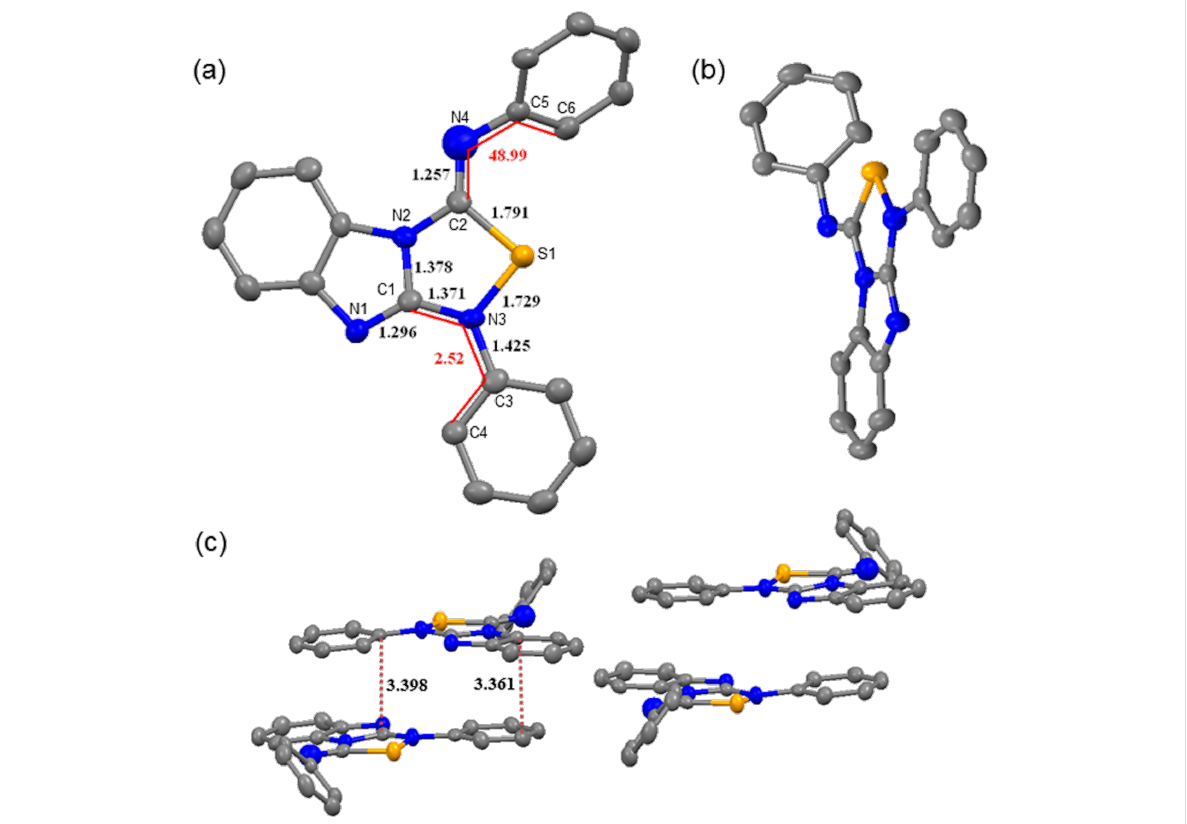
Figure 1: (a) and (b) representing the solid state structure of 2a with displacement ellipsoids at the 50% probability level. Distances are given in black (unit: Å) and dihedral angles in red (unit: deg). (c) represents the unit cell packing ( Z = 4) showing the π ··· π interaction distances.